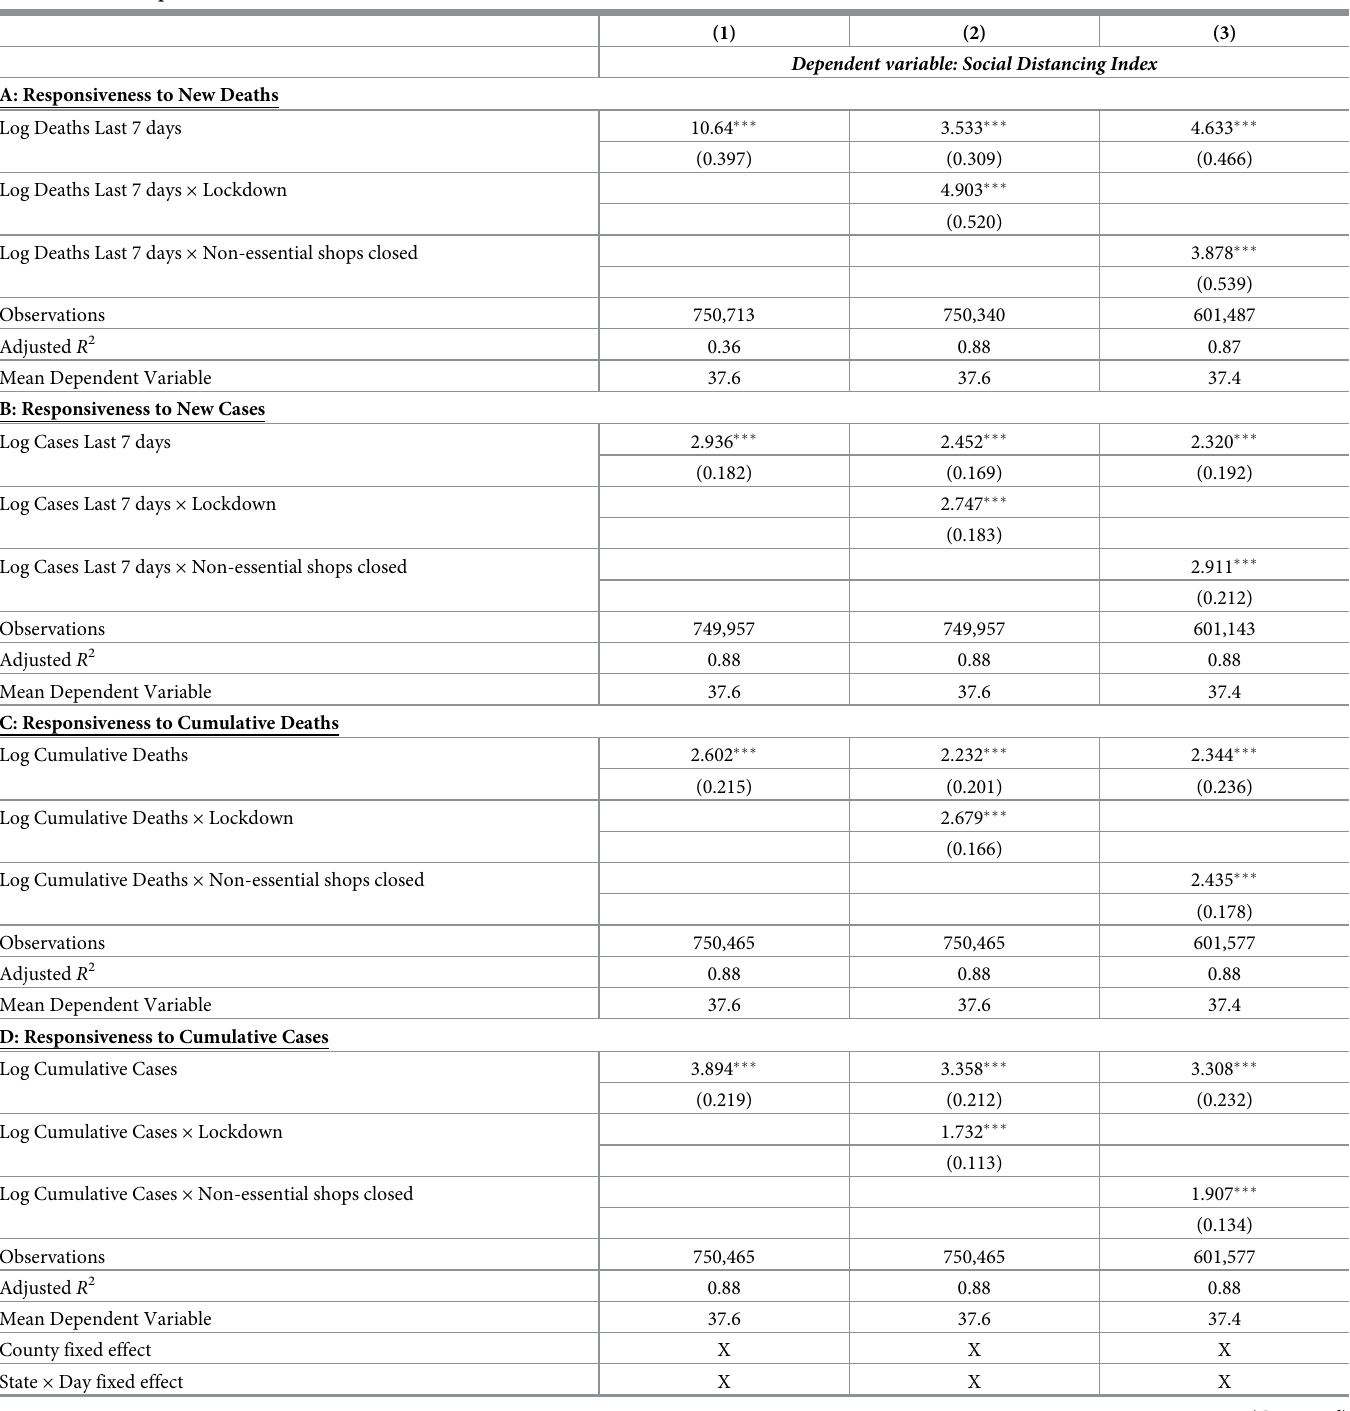
Table 2. Citizen responsiveness to COVID-19